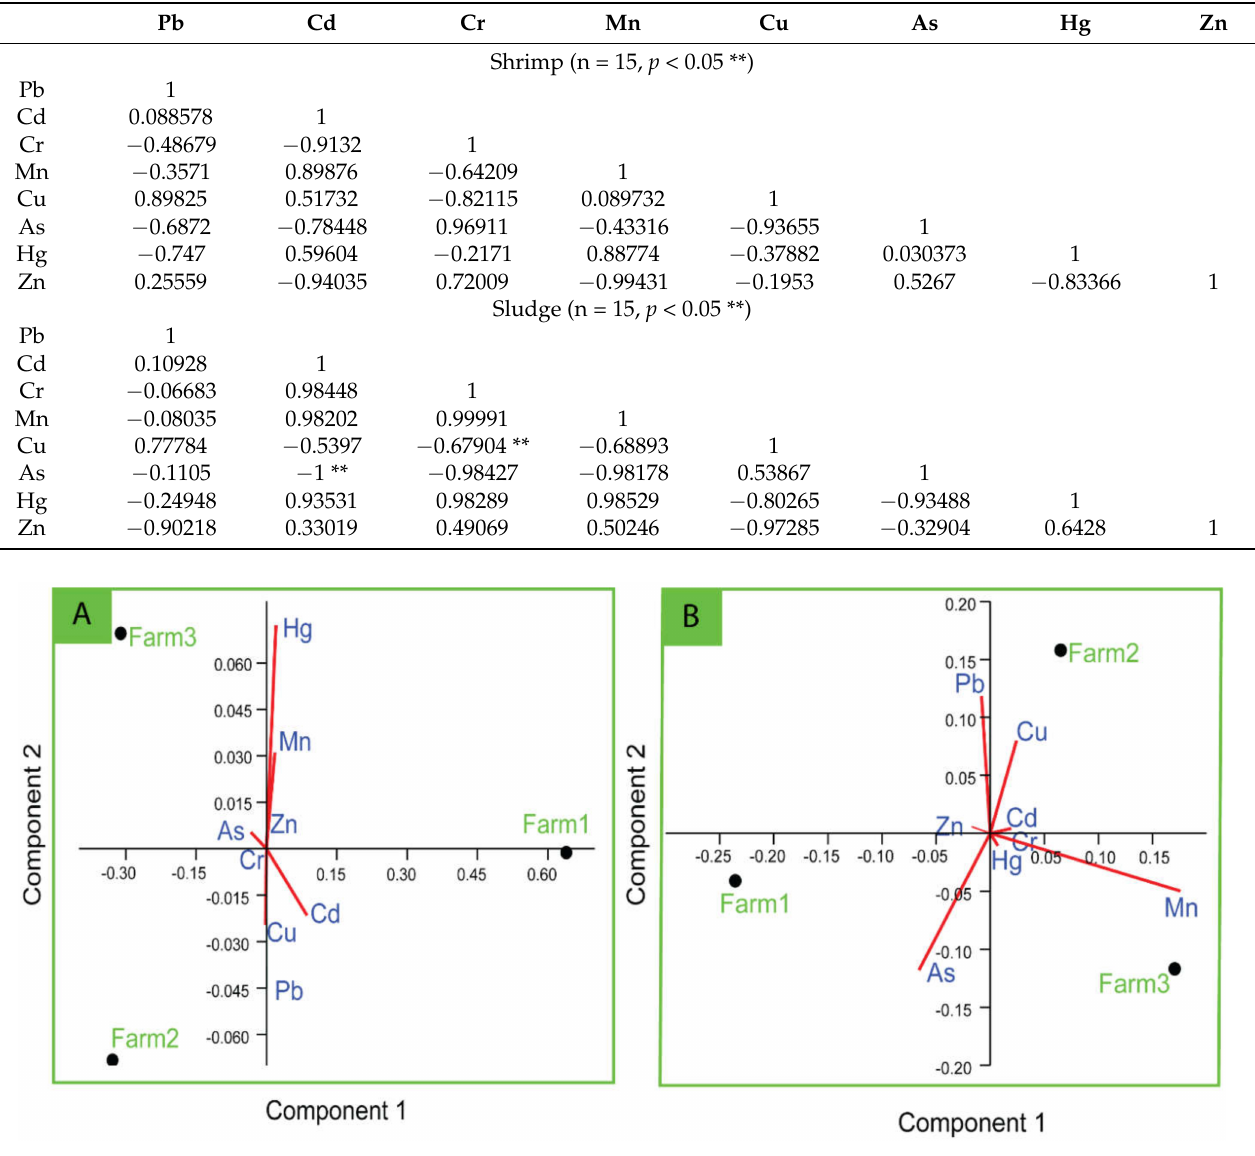
Table 4. Pearson correlation analysis of heavy metals in shrimp tissue and farm sludge ( p values less than 0.05 are indicated as **).